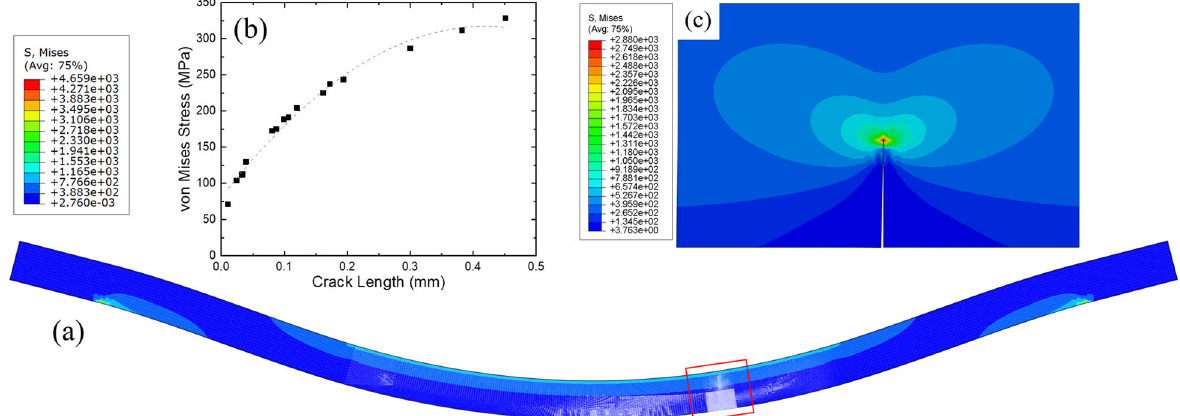
Fig. 7 FEA results. a Deformed 4-point bent specimen; b von Mises stress at different crack lengths for all cracked grain pairs; c high magni fi cation view of the stress distribution near the crack